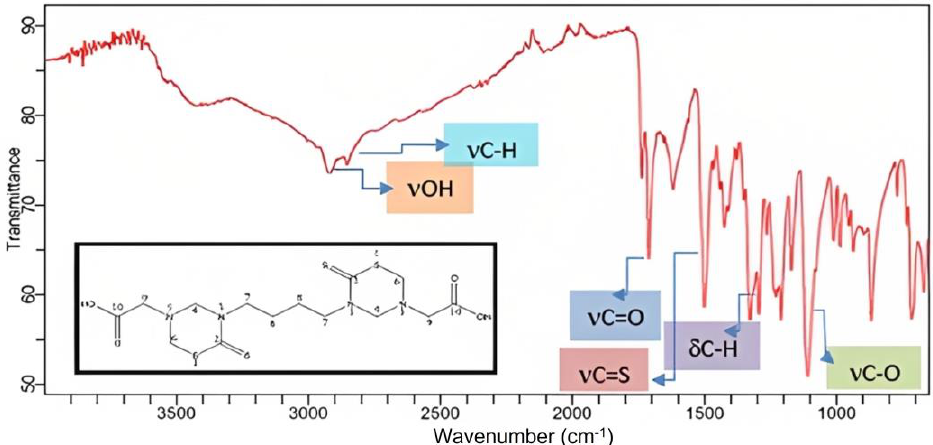
Figure 2. FT-IR absorption spectrum of 2-(5-{6-[5-(Carboxymethyl)-2-thioxo-1,3,5-thiadiazinan-3- yl]butyl}-6-thioxo-1,3,5-thiadiazinan-3-yl)-ethanico acid (JH1). On the X-axis are represented the wavenumber (cm −1 ) vs. transmittance on the Y-axis.